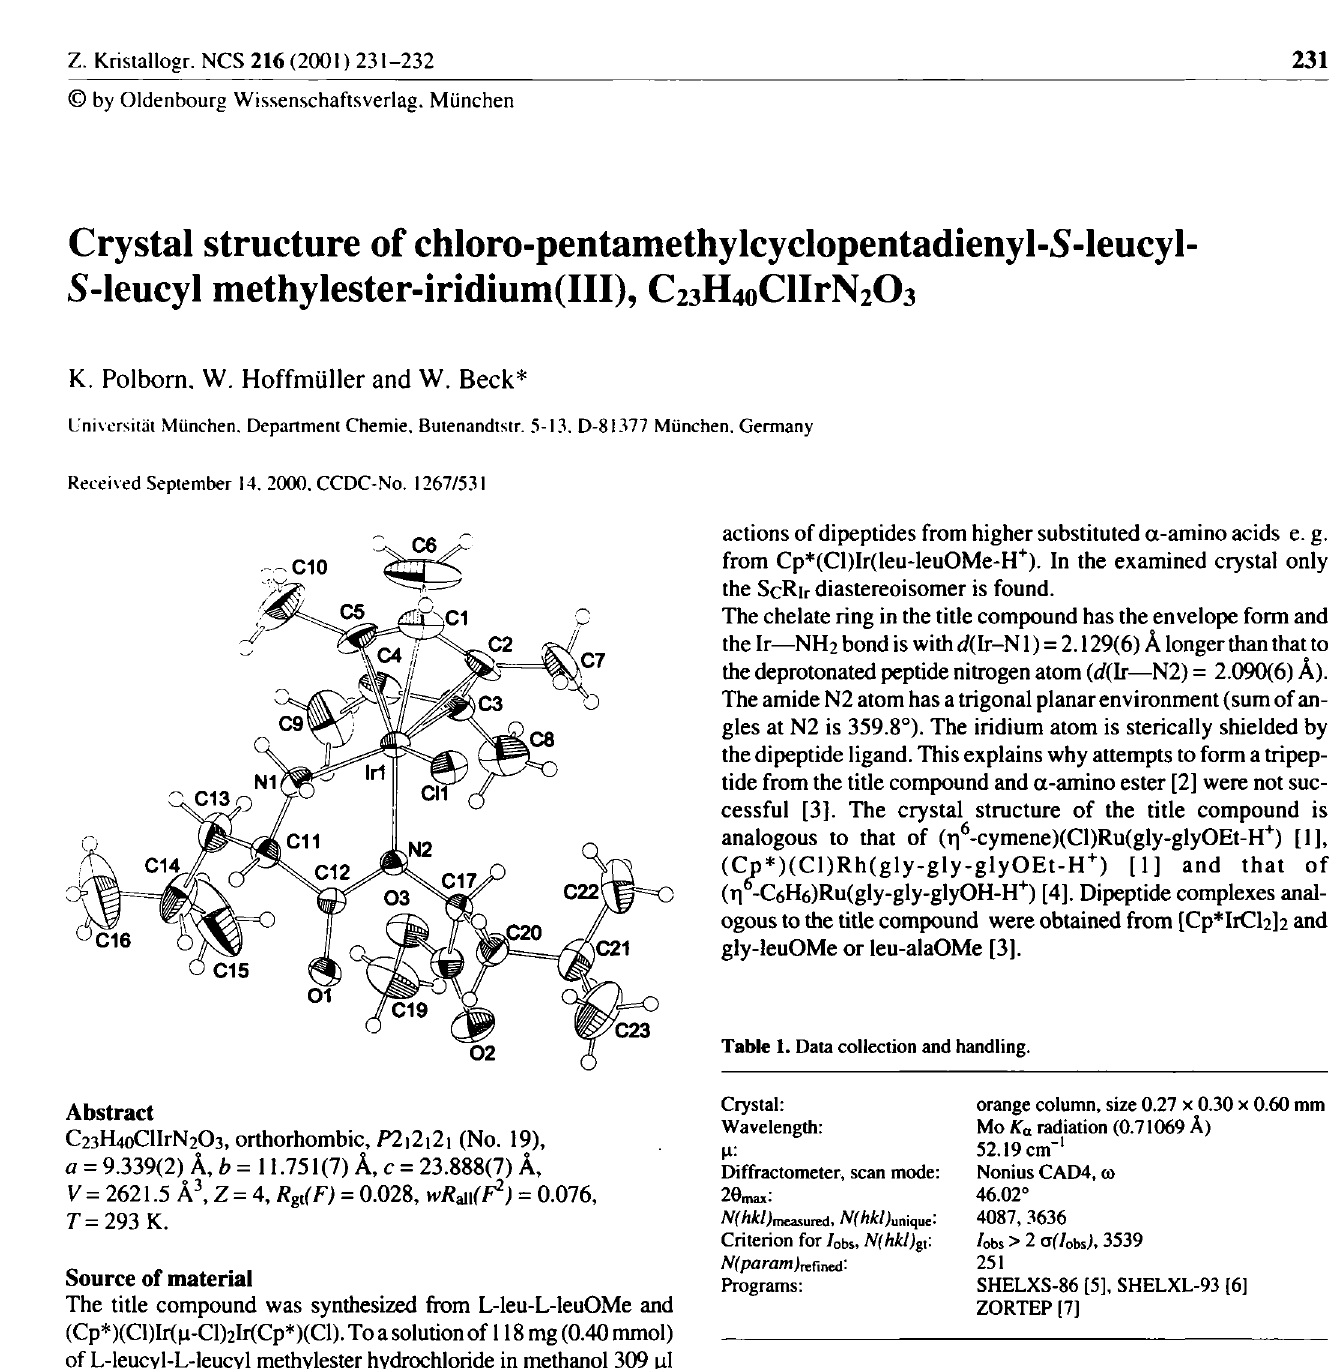
Table 2. Atomic coordinates and displacement parameters (in Ä 2